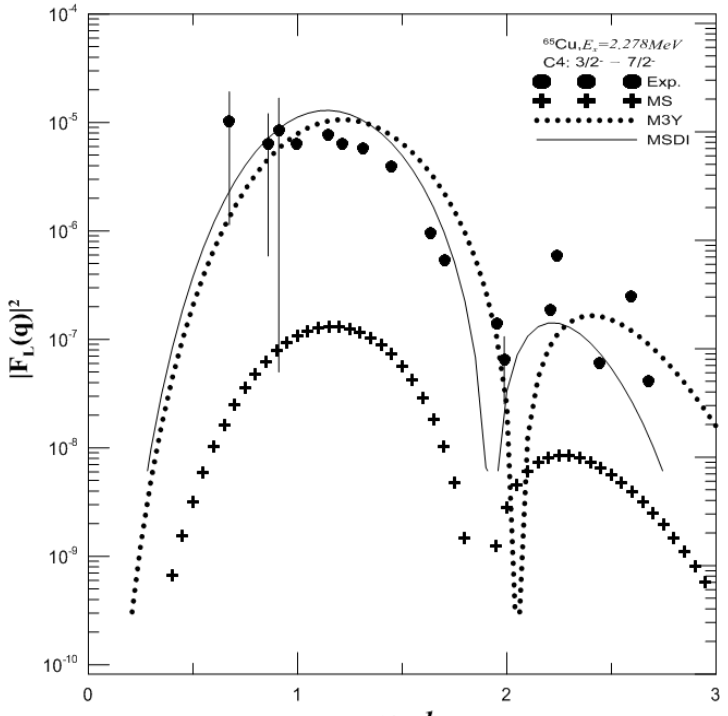
Fig.8: Inelastic longitudinal form factors for C4 transition 3/2 -  7/2 - in 65 Cu nucleus using MSDI and M3Y interactions with core-polarization effects, through particle-hole excitations up to 6ћω. The experimental data are taken from Ref. [28].